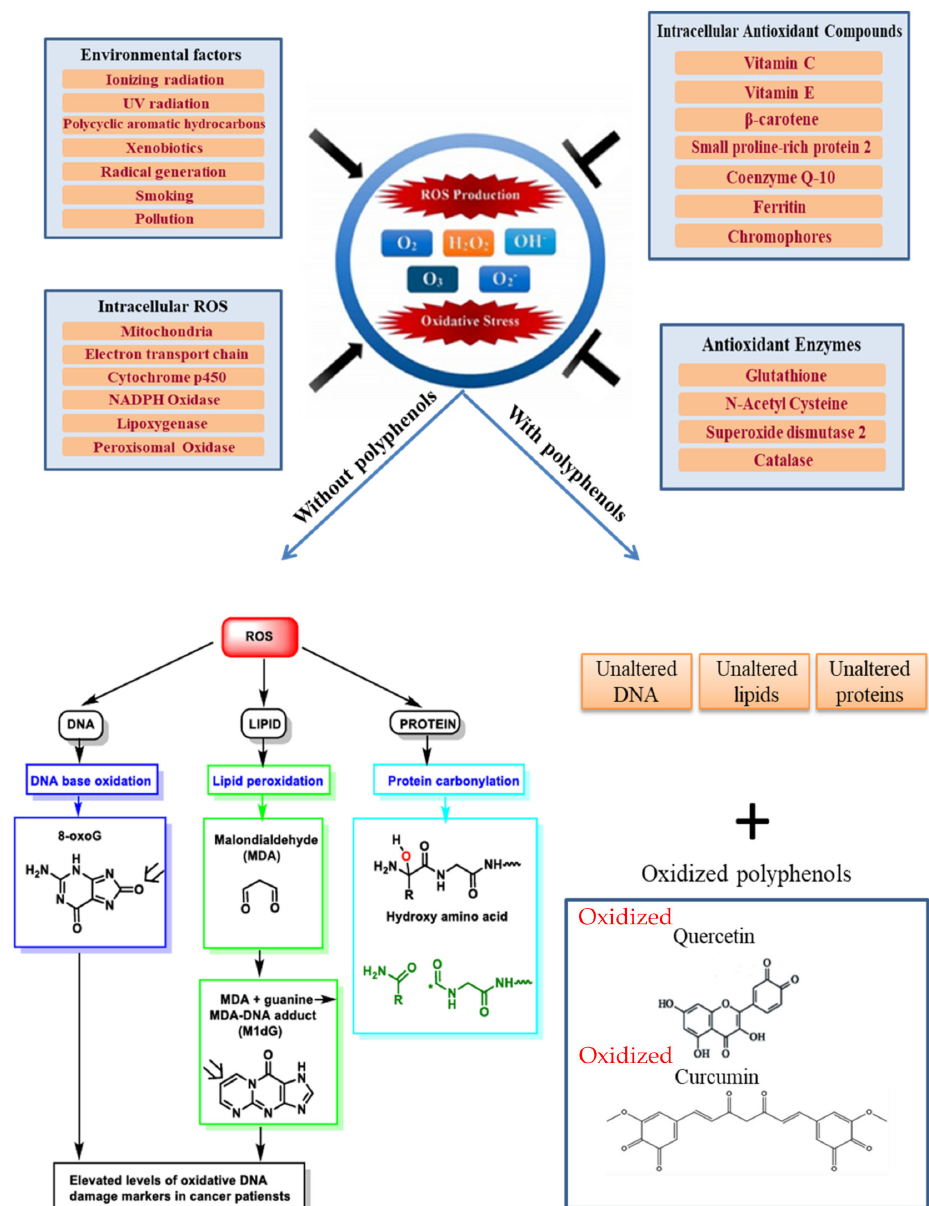
Figure 1. The ROS production, oxidative stress, and the balancing role of polyphenols, adapted according to